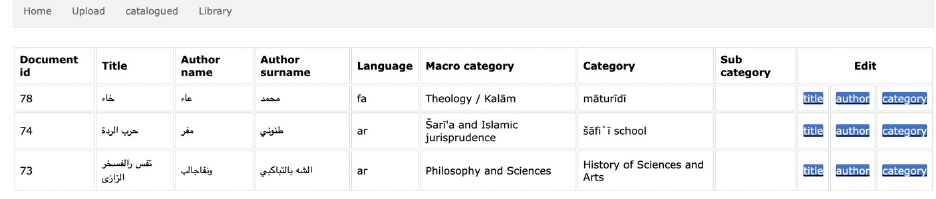
Figure 7. Preliminary resulting cataloguing tool prototype UI: catalogued documents summary. After the semi automatic selection of title, author name (and eventually surname), all selected data are put together in the cataloguing interface in relation to a specific topic and field which represents a category (or sub-category) of the library. Title, author name and surname are shown in the original language (arabic script) as shown here in the figure.